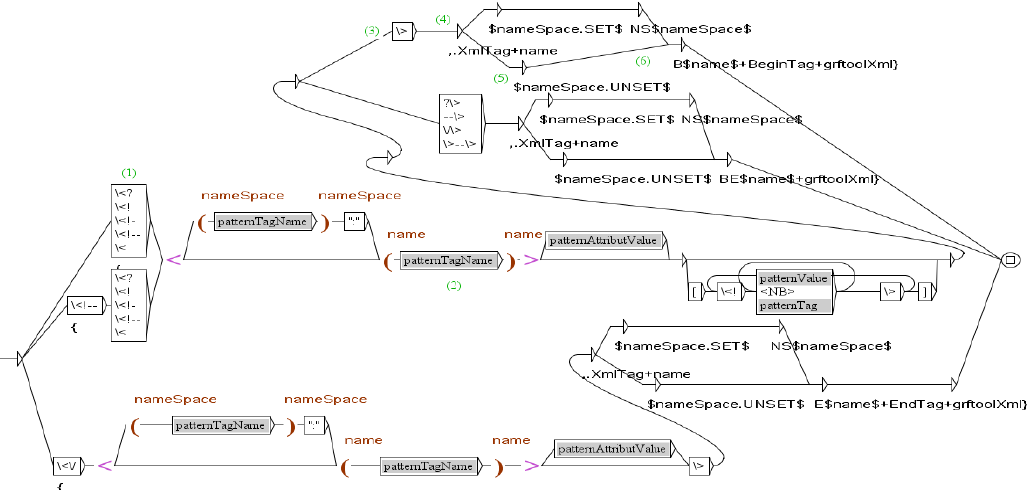
Figure 1. The graph to encapsulate XML